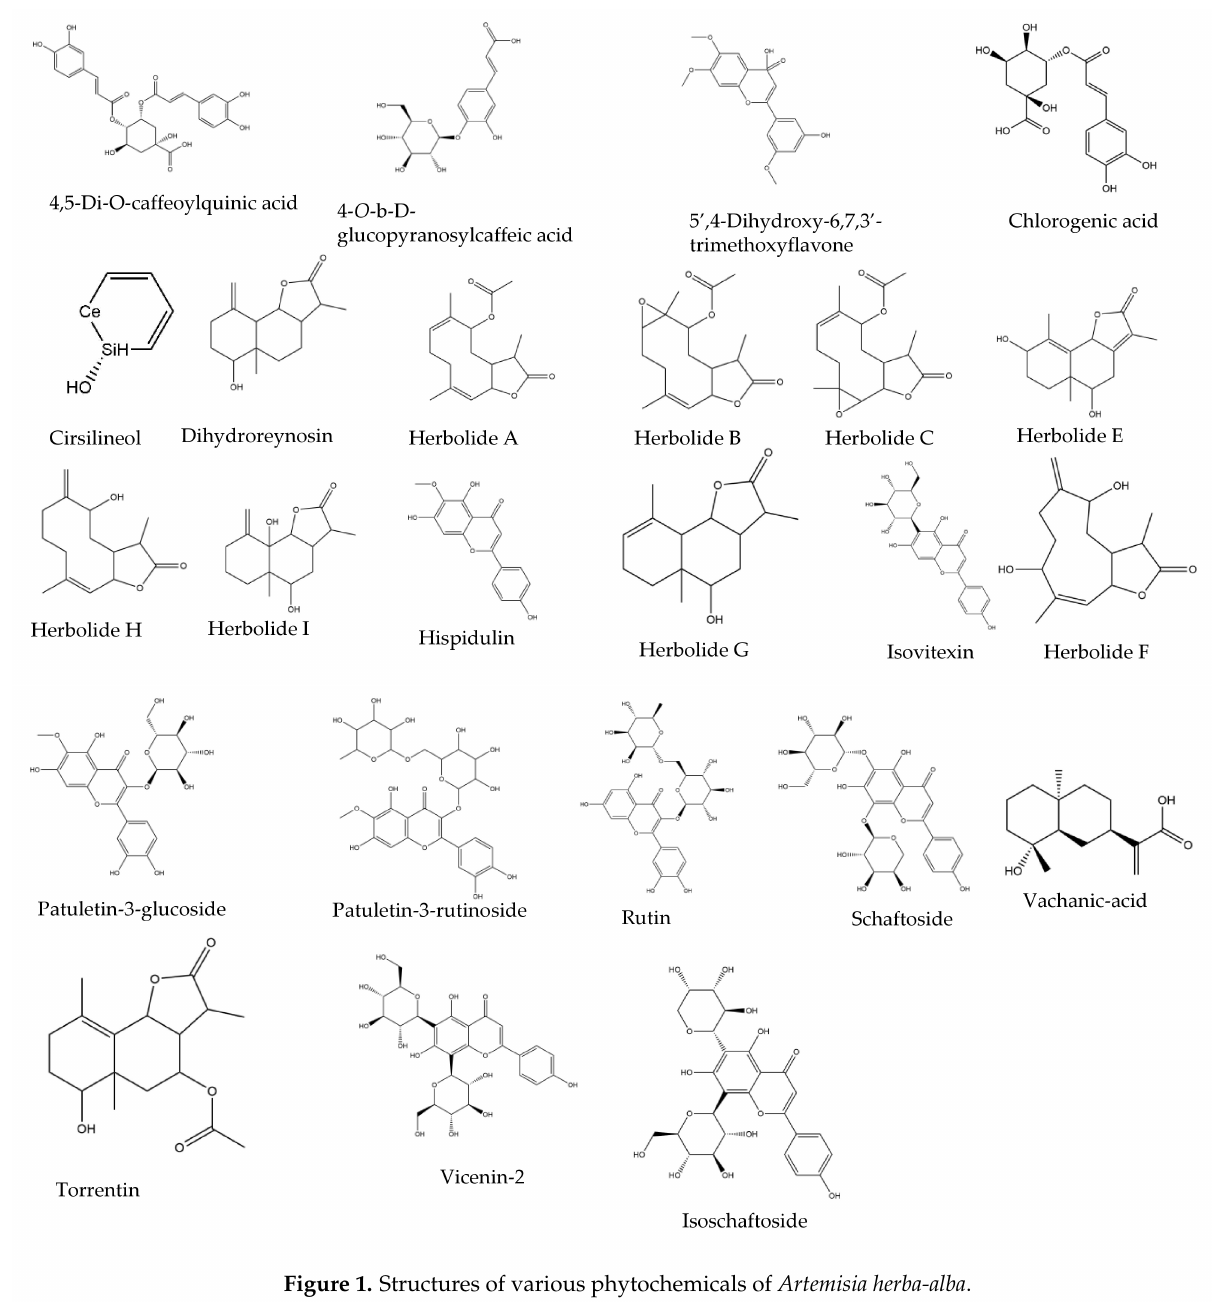
Figure 1. Structures of various phytochemicals of Artemisia herba-alba . The non-bonding interactions of the Artemisia herba-alba phytochemicals (top three compounds with highest binding affinities to Mpro amino acid residues) are shown in Table 2. These three compounds are rutin, 4,5-di- O -caffeoylquinic acid, and schaftoside, with predicted binding energies, respectively, of − 8.8, − 8.5, and − 8.3 kcal/mol. Mpro is 306 amino acids long; it has been reported to contain a catalytic dyad comprising of His41 and Cys145. The protease exists as a dimer, with the monomeric form being essentially inactive [64,65]. Each monomer contains three domains; domain 1 comprises amino acid residues 8–101, domain 2 contains amino acid residues 102–184, and domain 3 contains residues 201–306. A loop region (amino acid residues 185–200) connects domain 2 with domain 3. The substrate-binding site location is within a cleft formed between domains 1 and 2 [66]. The interactions of the three phytochemicals, as shown in Table 2, demonstrate that all three phytochemicals bind to one or both amino acids of the catalytic dyad and mainly form strong interactions with the amino acid residues of domain 2. The